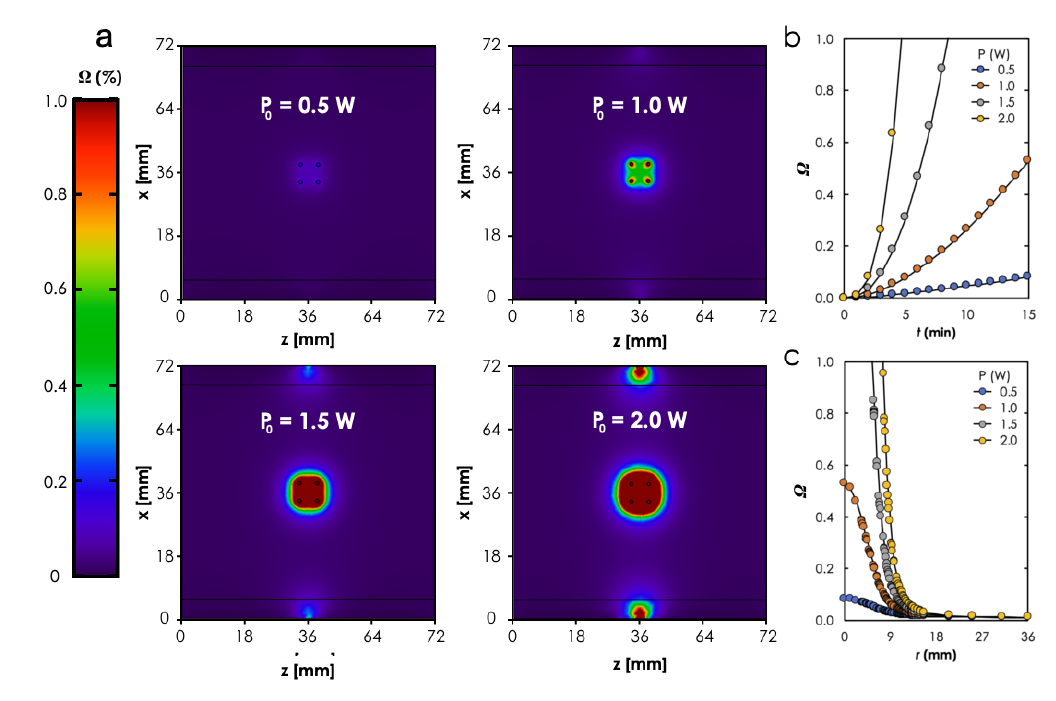
Figure 7. FEM Simulation results. ( a ) Comparison of the cross-sectional views (zx-plane) thermal distributions for different P 0 . Thermal damage as a function of ( b ) time at and ( c ) distance away from point P 1. Study parameters: P 0 = 0.5–2.0 W, t = 15 min.